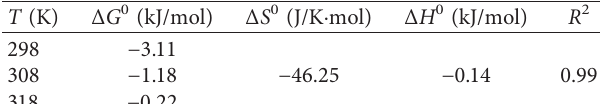
typified by slow evolution to equilibrium and ad- sorption kinetic realized at pseudo-second-order